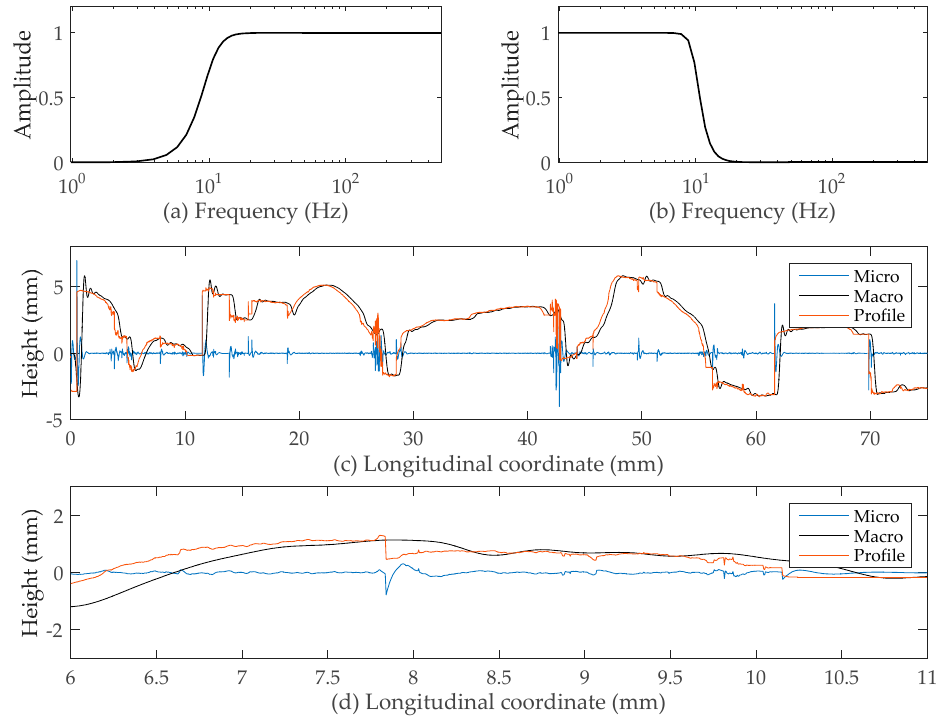
Figure 6. ( a ) Amplitude response of Butterworth’s high-pass filter; ( b ) low-pass filter; ( c ) profile with filtered micro-texture and macro-texture; ( d ) close-up of the profile.